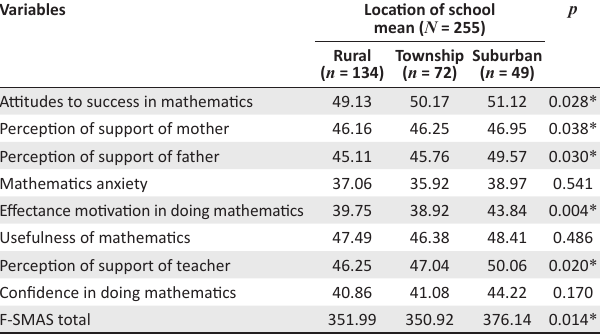
TABLE 7: Differences in attitudes towards mathematics amongst rural, township and suburban students. Variables